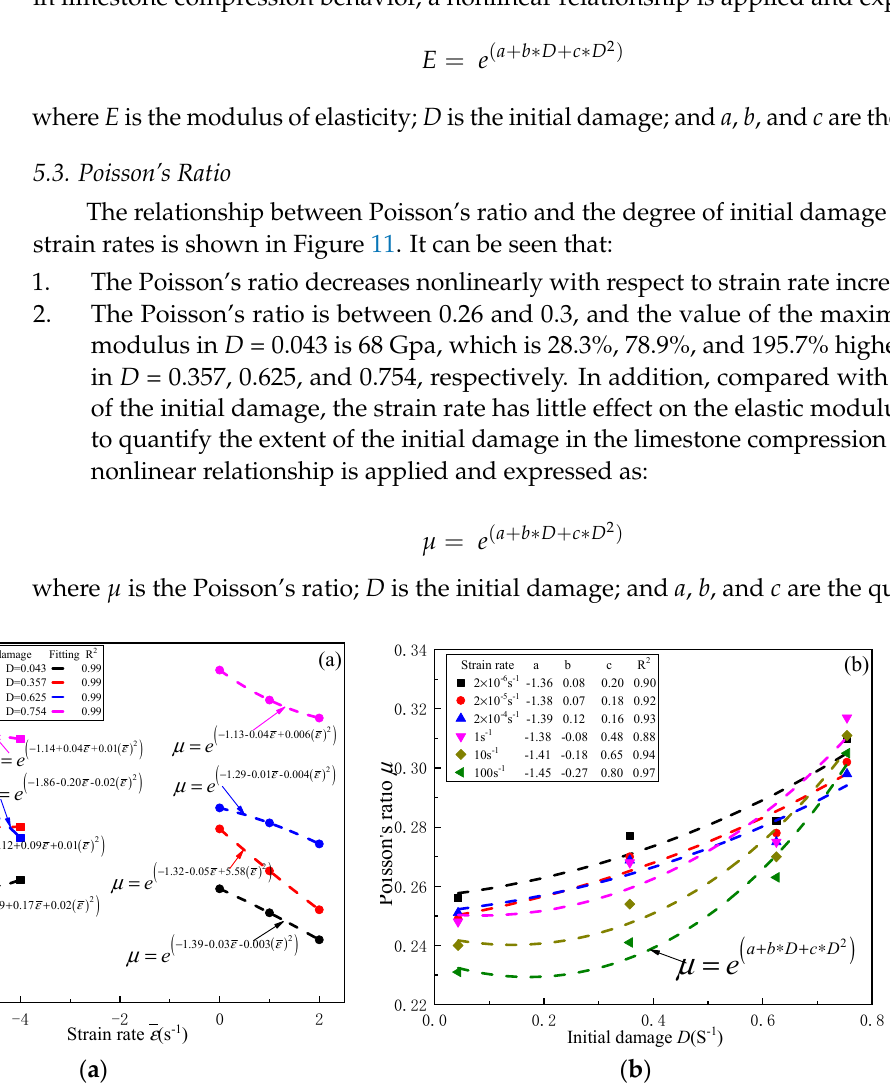
Figure 10. Plot of the elastic modulus versus the initial damage for the axial test from 2 × 10 − 6 s − 1 to 100 s − 1 levels of strain rate: ( a ) E − ; ( b ) E-D .